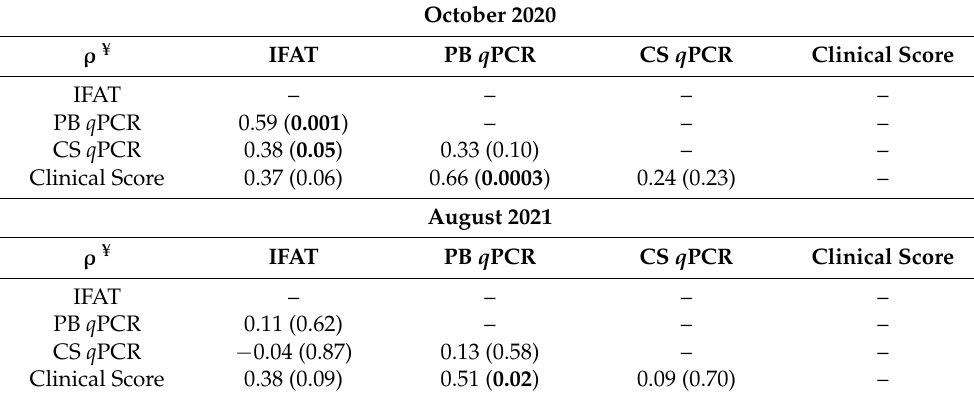
Table 6. Correlation matrix based on Spearman rank correlation coefficient ( ρ ) between